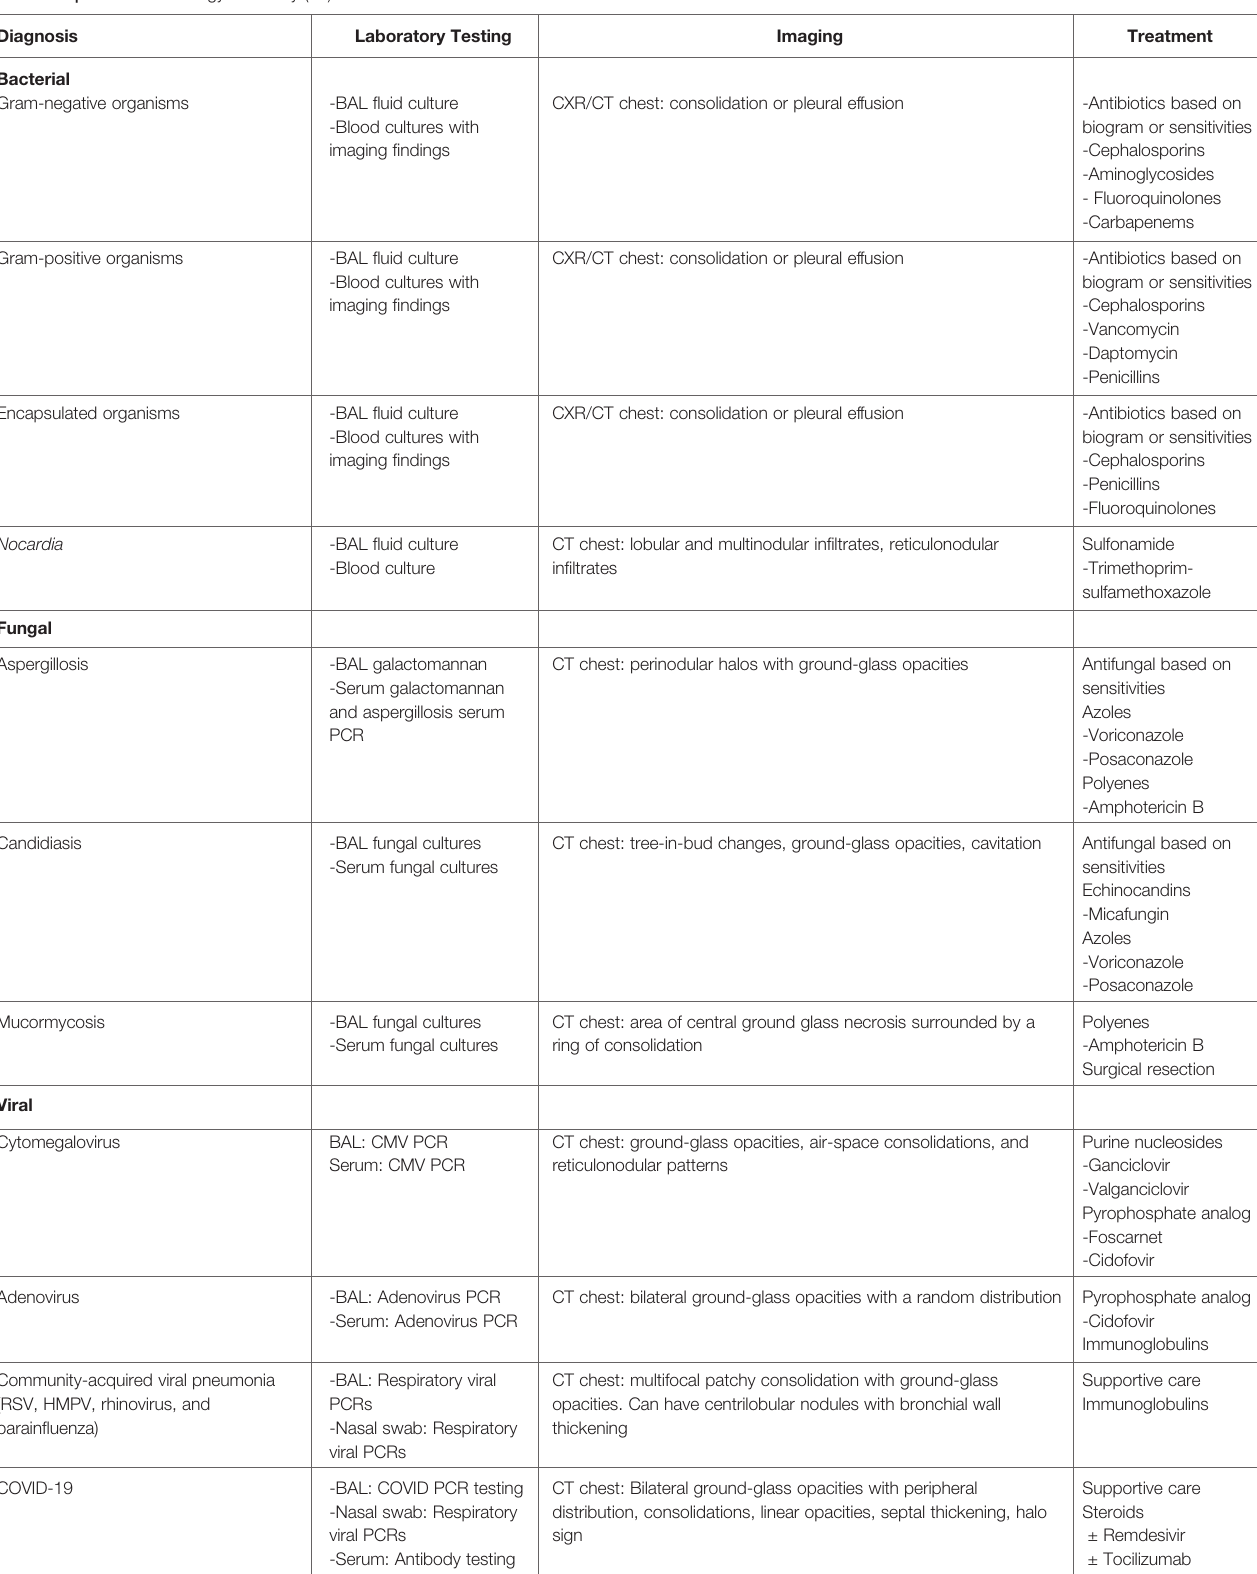
TABLE 2 | Infectious etiology summary